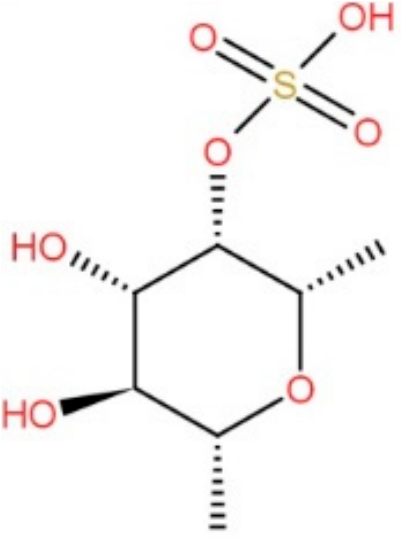
Figure 4. Basic chemical structure of fucoidan.